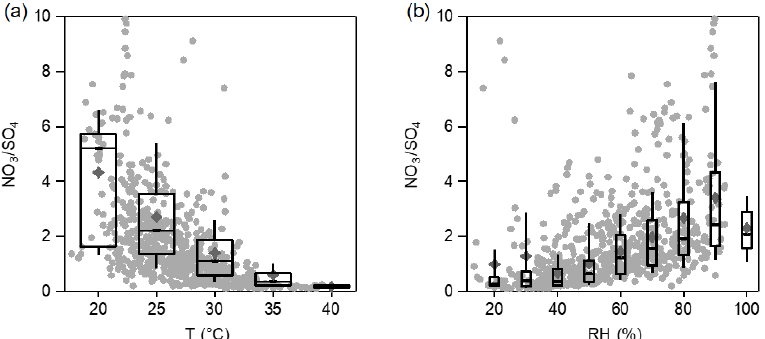
Figure 7. Variations in the nitrate / sulfate mass ratio as a function of (a) temperature ( T ) and (b) relative humidity (RH). The data were binned according to T and RH, and the mean (cross), median (horizontal line), 25th and 75th percentiles (lower and upper box), and 10th and 90th percentiles (lower and upper whiskers) are shown for each bin.